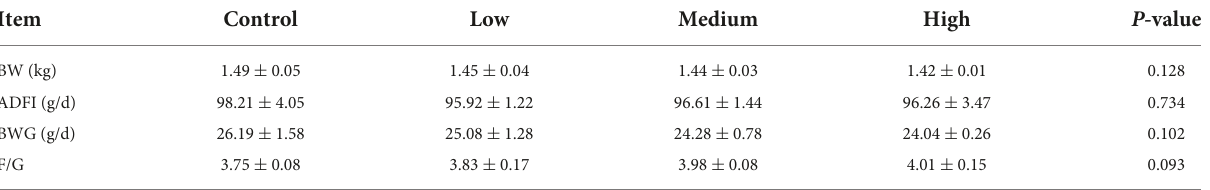
TABLE 3 Effects of dietary linseed oil supplementation on growth performance of 28–56 days ducks.